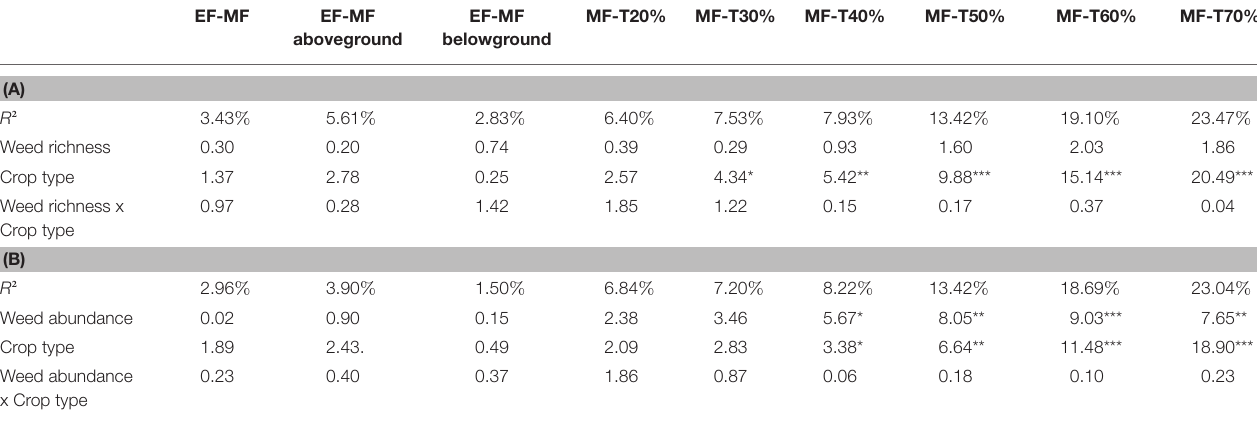
TABLE 1 | F-Statistics for the effects of weed richness (A) or weed abundance (B), crop type and their interaction on ecosystem multifunctionality computed as the sum of all standardized ecological functions (EF-MF), aboveground ecological functions (EF-MF aboveground), belowground ecological functions (EF-MF belowground) and using a threshold approach (with threshold from 20 to 70%).